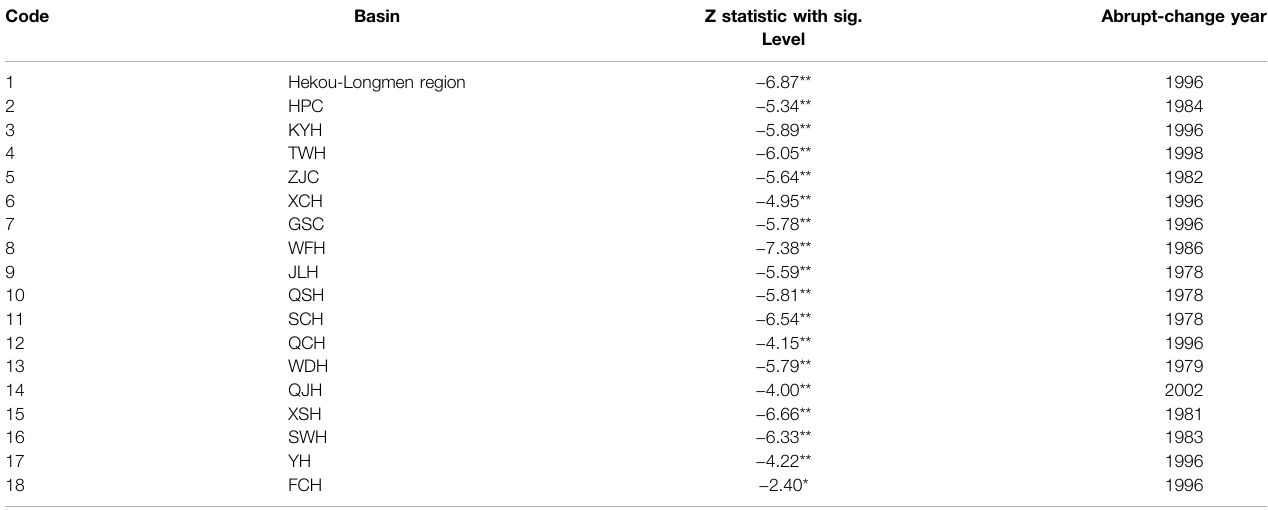
TABLE 1 | Variation trend of sediment loads in the Hekou-Longmen region. Code Basin Z statistic with sig.